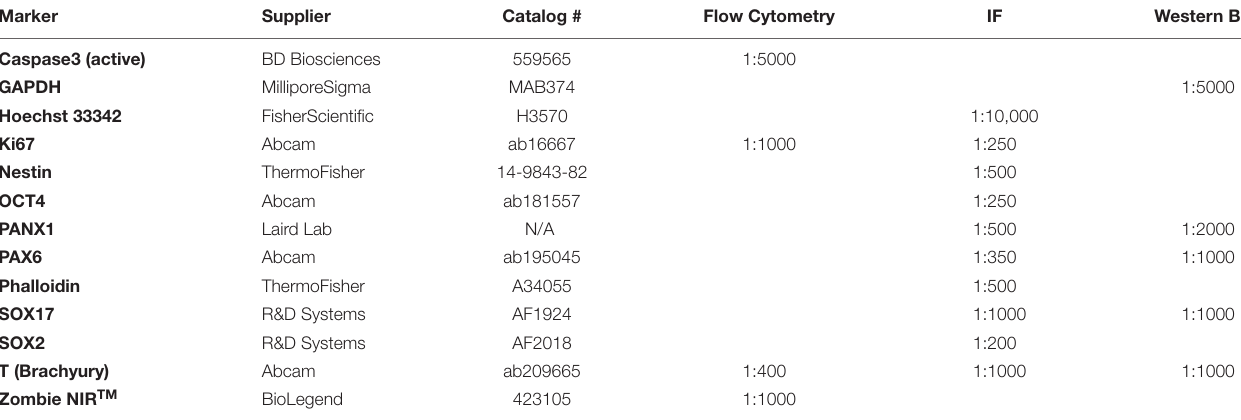
TABLE 2 | Primary antibodies and dyes. Marker